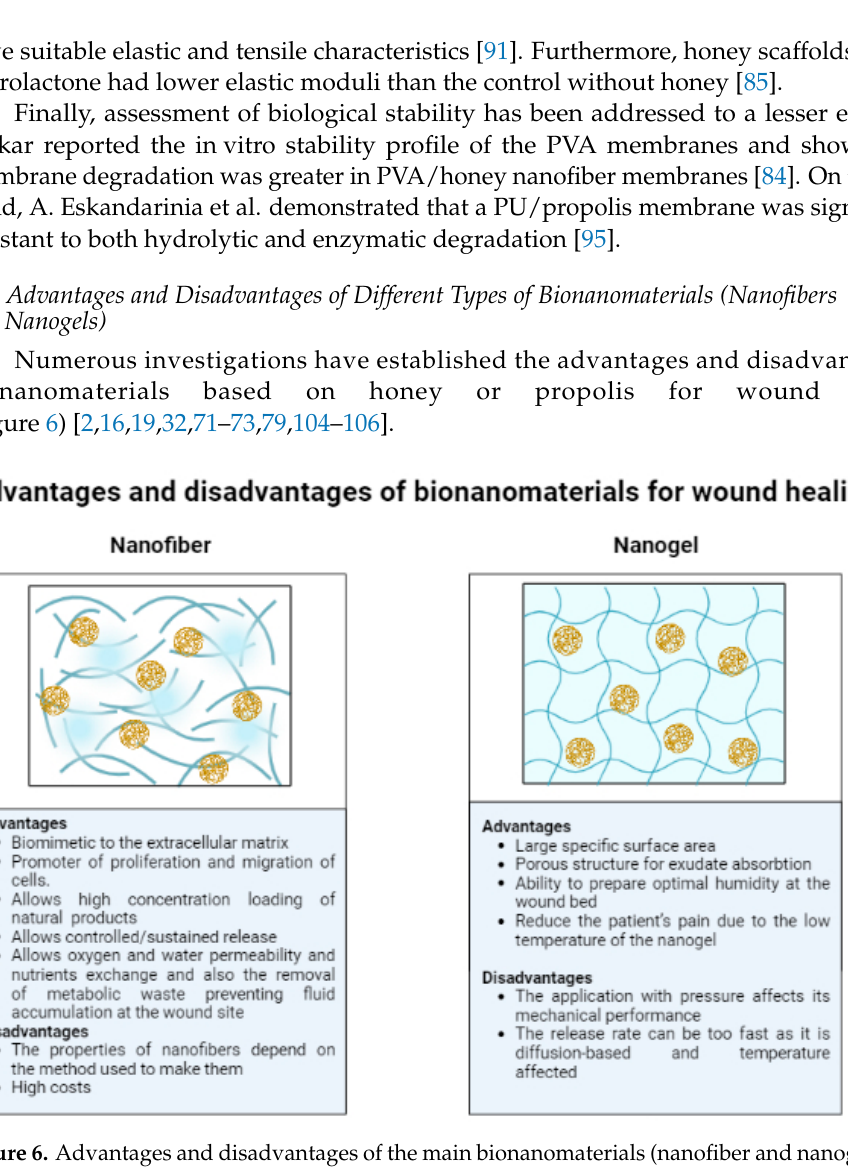
Table 3. Patents, publication date, applicant and description of bionanomaterial based on honey or propolis.